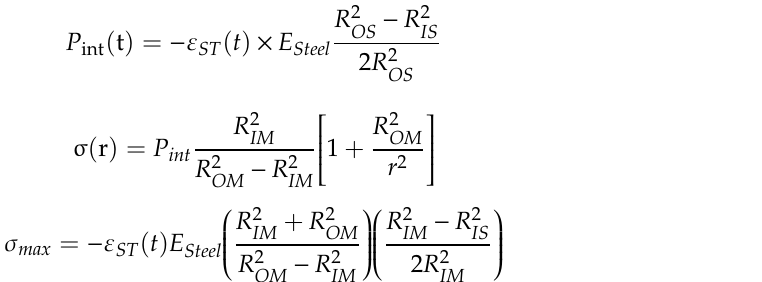
Figure 5 . Test specimen of RRST. ( a ) RRST molds; ( b ) RRST specimen